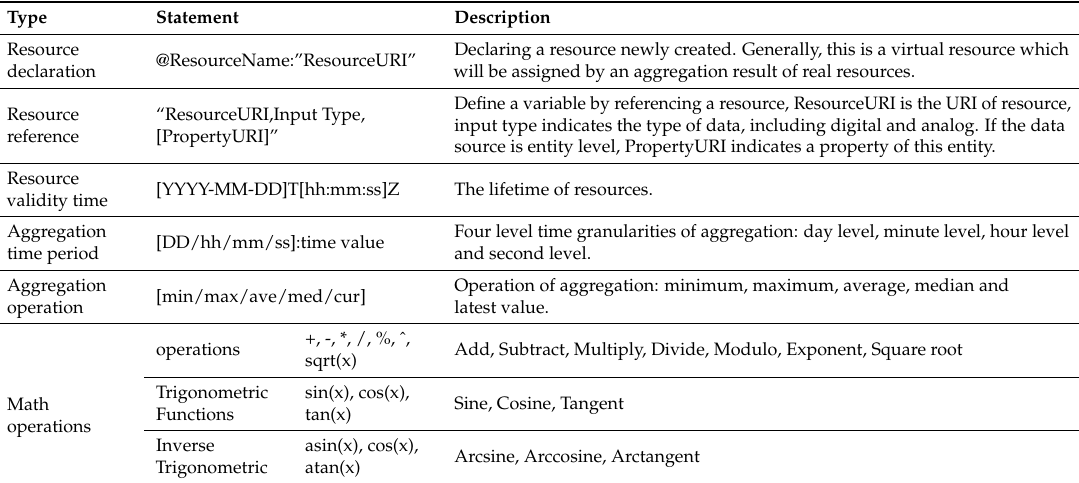
Table 1. Summary of the DML